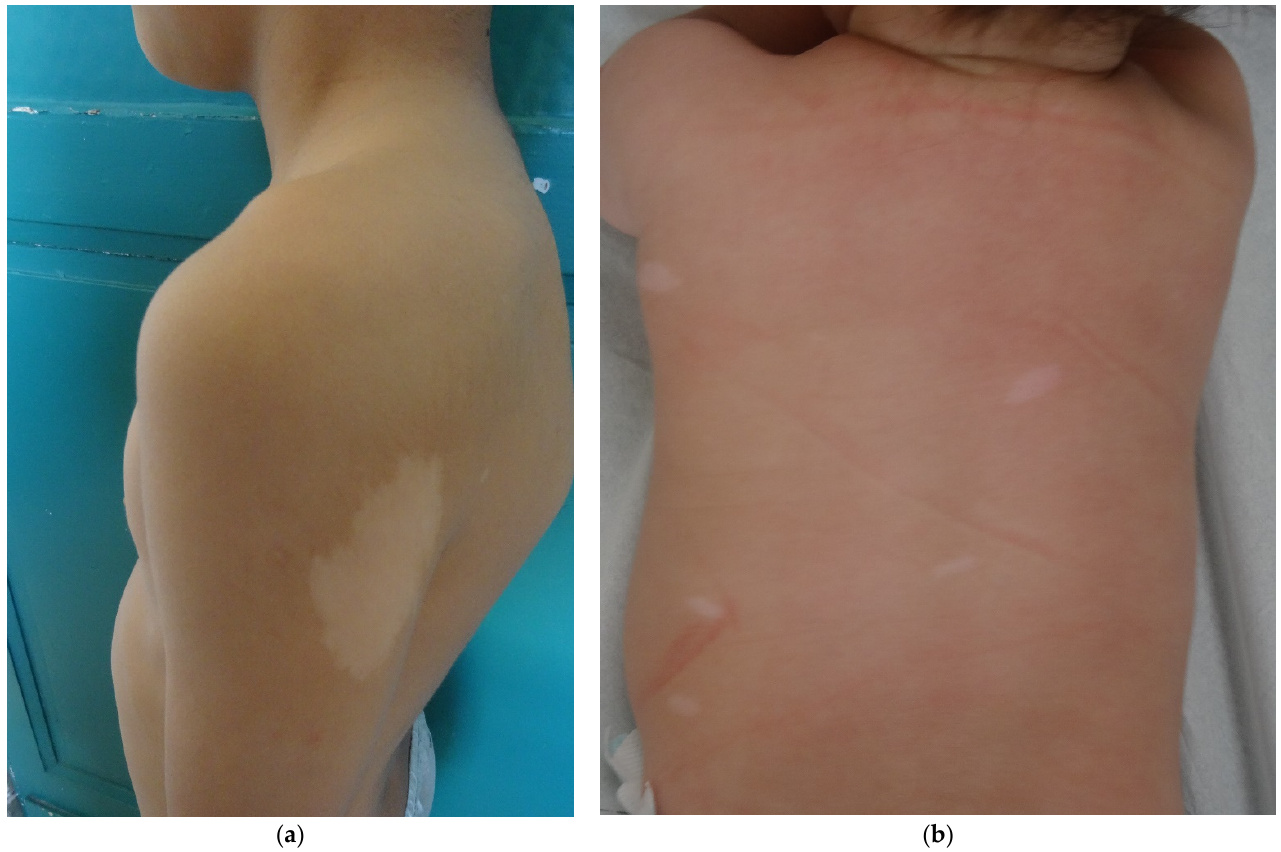
Figure 1. Hypomelanotic macules. ( a ): Ash leaf spot hypomelanotic lesion in a 7 year-old boy’s arm; ( b ): lance-ovate hypomelanotic macules in a 4 months boy’s back.